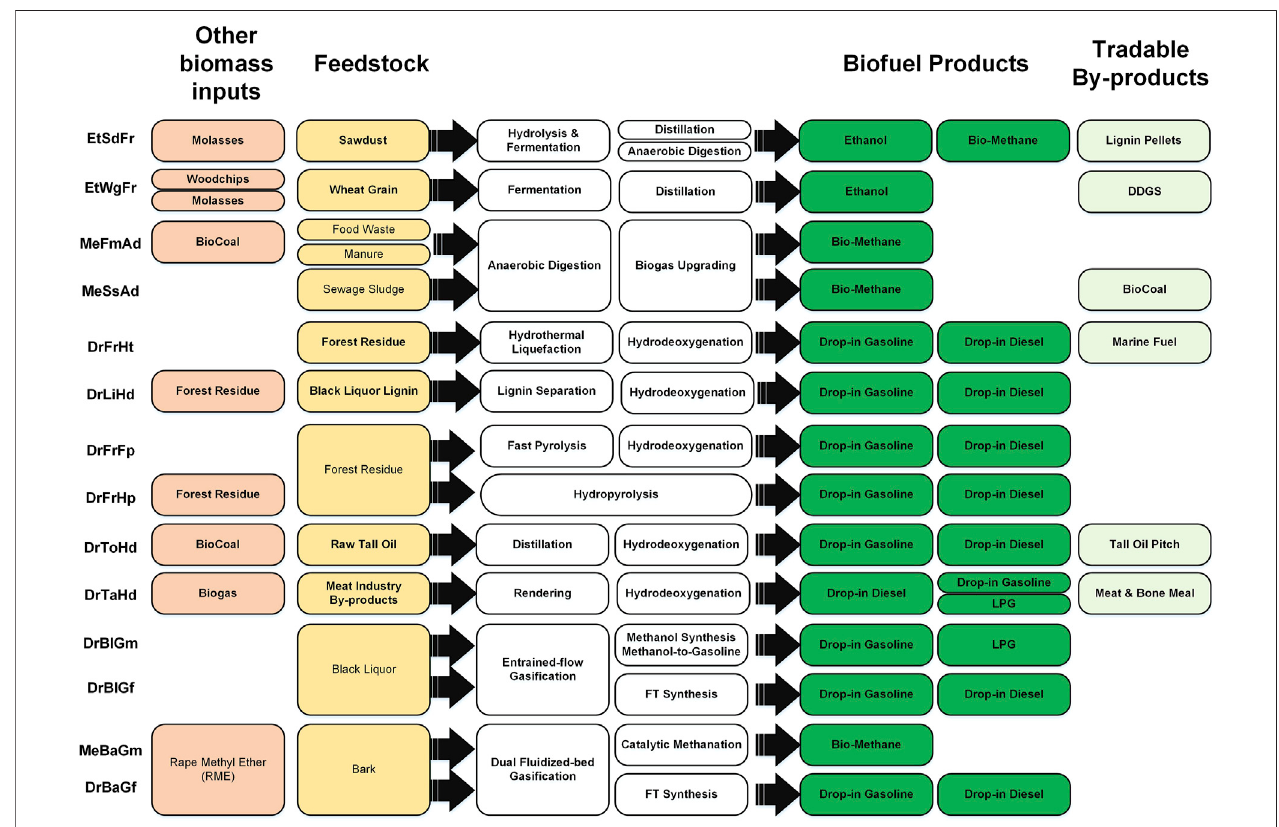
FIGURE 1 | Feedstocks, biofuel products and principal conversion technologies for the pathways studied.